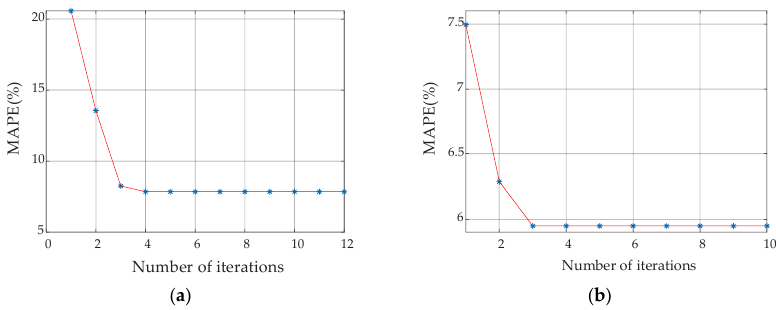
Figure 12. Variation of MAPE with iteration steps based on the PSO–Powell hybrid algorithm at 1.398 T: ( a ) Global optimization by PSO algorithm; ( b ) Local optimization by Powell algorithm.